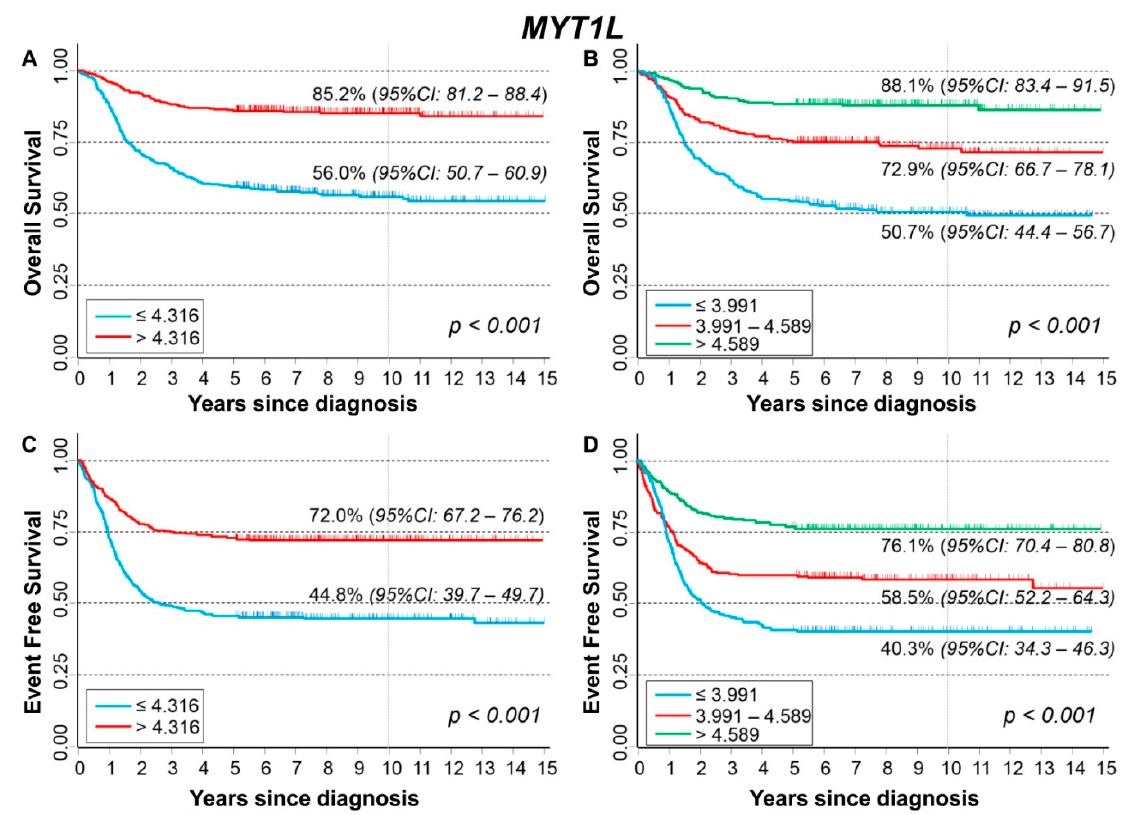
Figure 5. Patient Survival in relation to MYT1L expression level. Overall Survival of 786 NB patients with ( A ) cut-off based on the median expression value or ( B ) on tertile expression values. Event Free Survival of 769 NB patients with ( C ) cut-off based on the median expression value or ( D ) on tertile expression values. Ten-year survival estimates are displayed. Table 4. Overall Survival of 786 NB patients in relation to MYT1L expression levels evaluated by the Cox model.